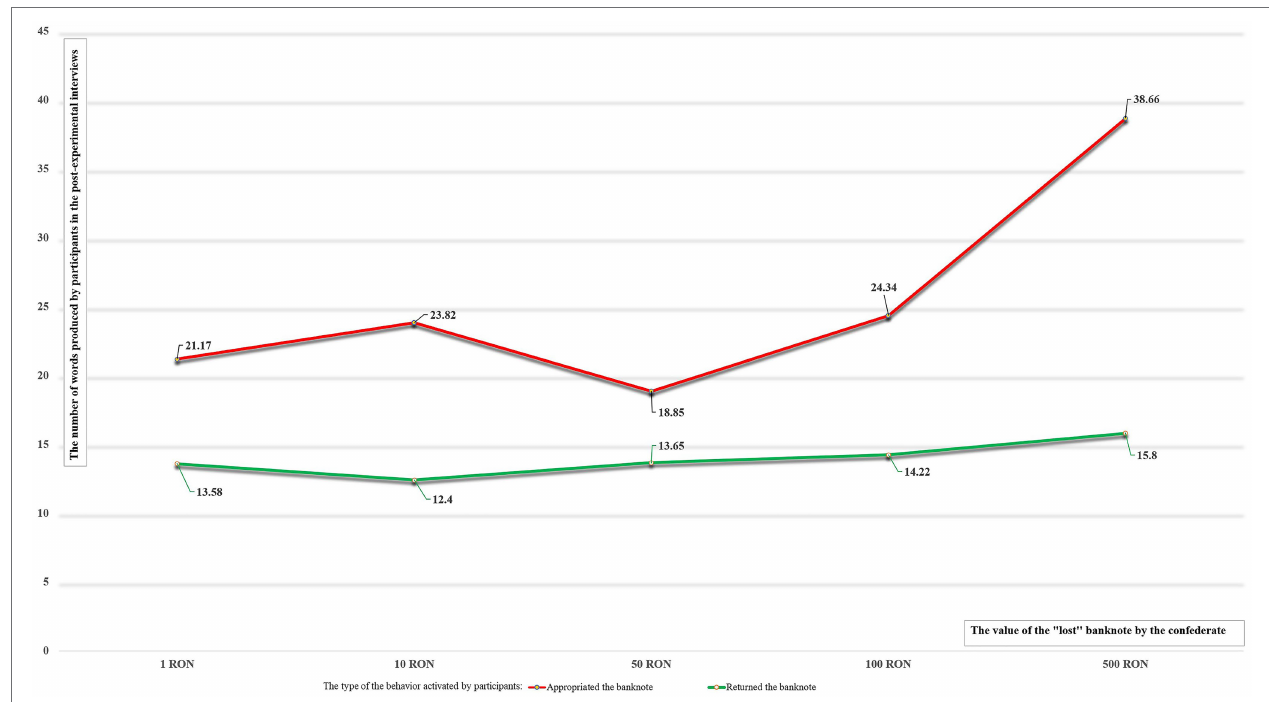
FIGURE 1 | Number of words produced in the post-experimental interviews as a function of returning behavior and value of the lost